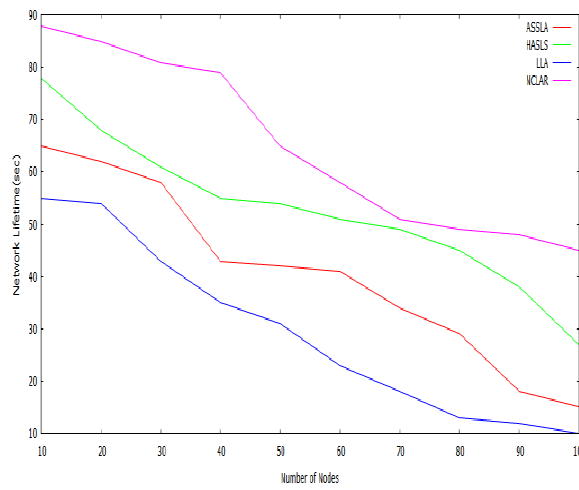
Figure 9. End to end delay Vs